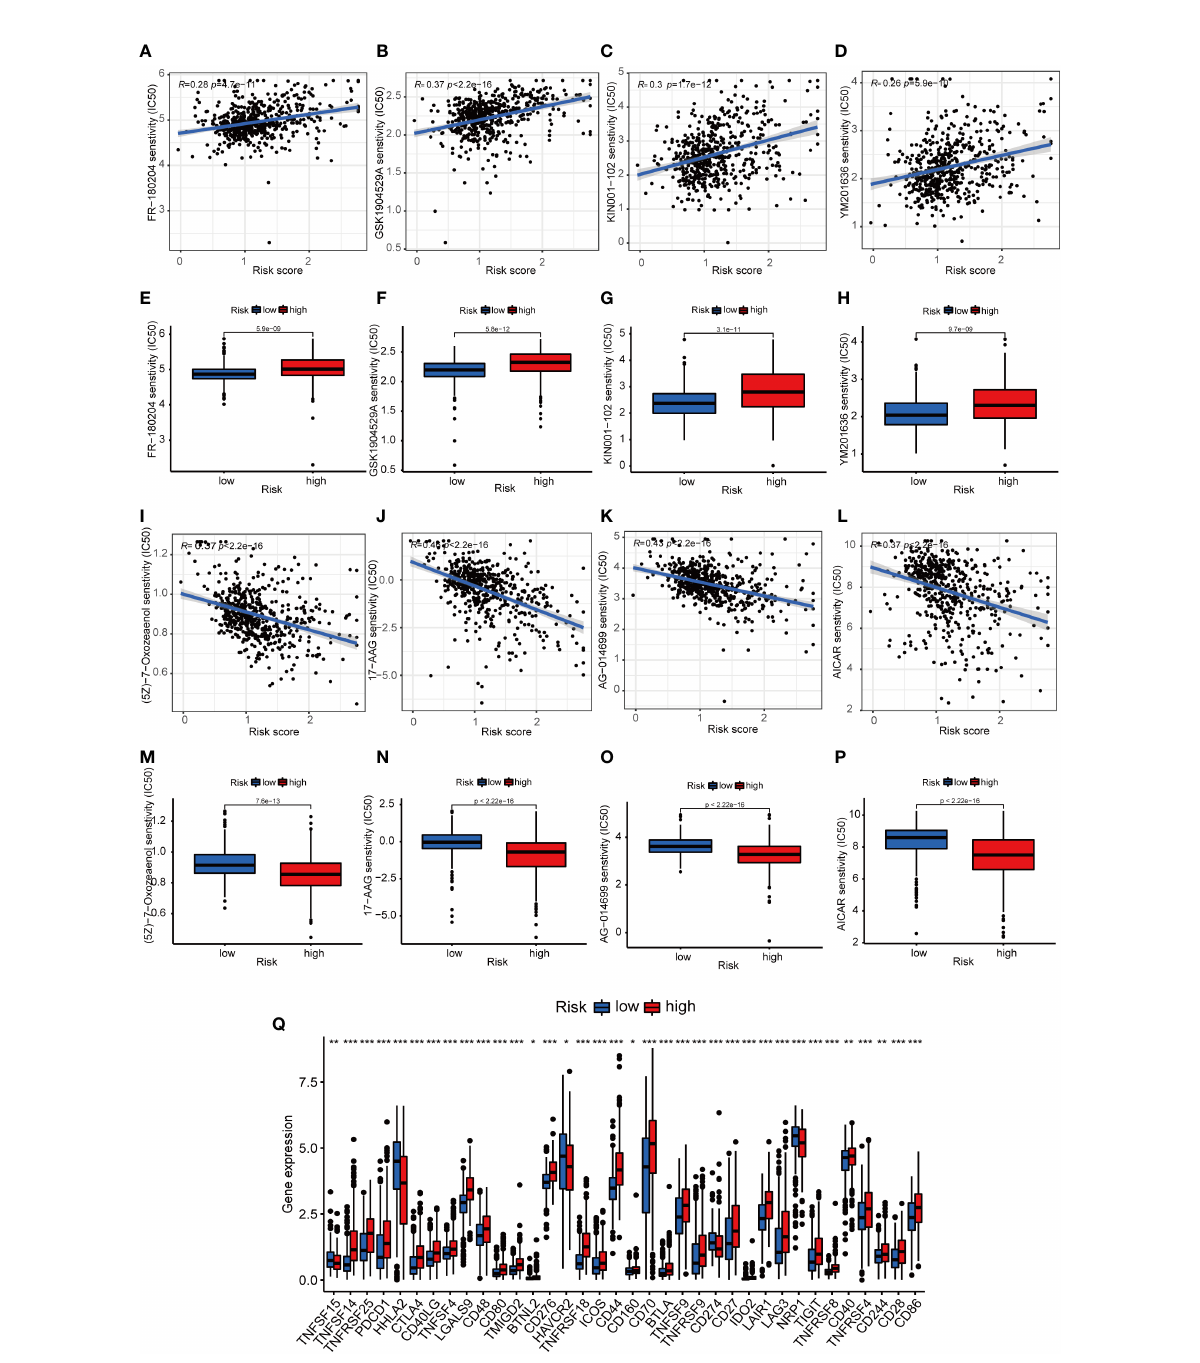
FIGURE 8 The immunotherapeutic prognosis for risk-dependent groups. (A – D) . The negative association of patients ’ risk scores with IC50 values for chemotherapeutics. (E – H) . IC50 values for chemotherapeutics in the HRS group were higher compared to the LRS group. (I – L) . The negative association of patients ’ risk scores with the IC50 values of chemotherapeutics. (M – P) . The IC50 values of chemotherapeutic agents were lower in the HRS group compared to the LRS group. (Q) . The expression levels of 18 checkpoints in various risk categories. * p < 0.05, ** p < 0.01, and *** p <